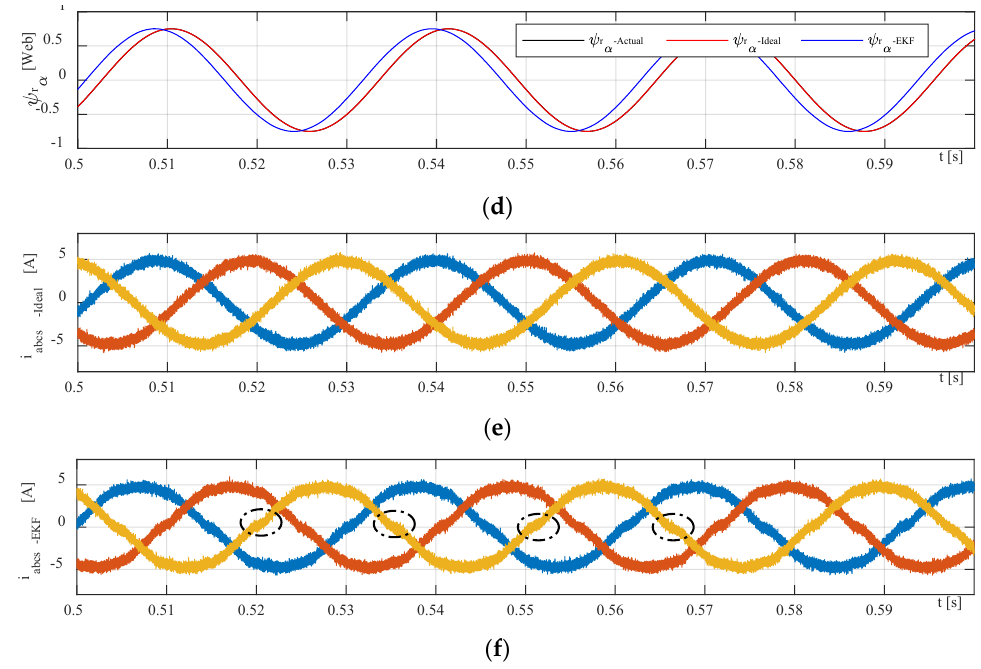
Figure 8. The EKF estimation results in zoomed version for ( a ) speed, ( b ) load torque, ( c ) alpha-term current, ( d ) rotor alpha-term flux, ( e ) actual stator three-phase currents for the ideal model, and ( f ) actual stator three-phase currents for the DT model.